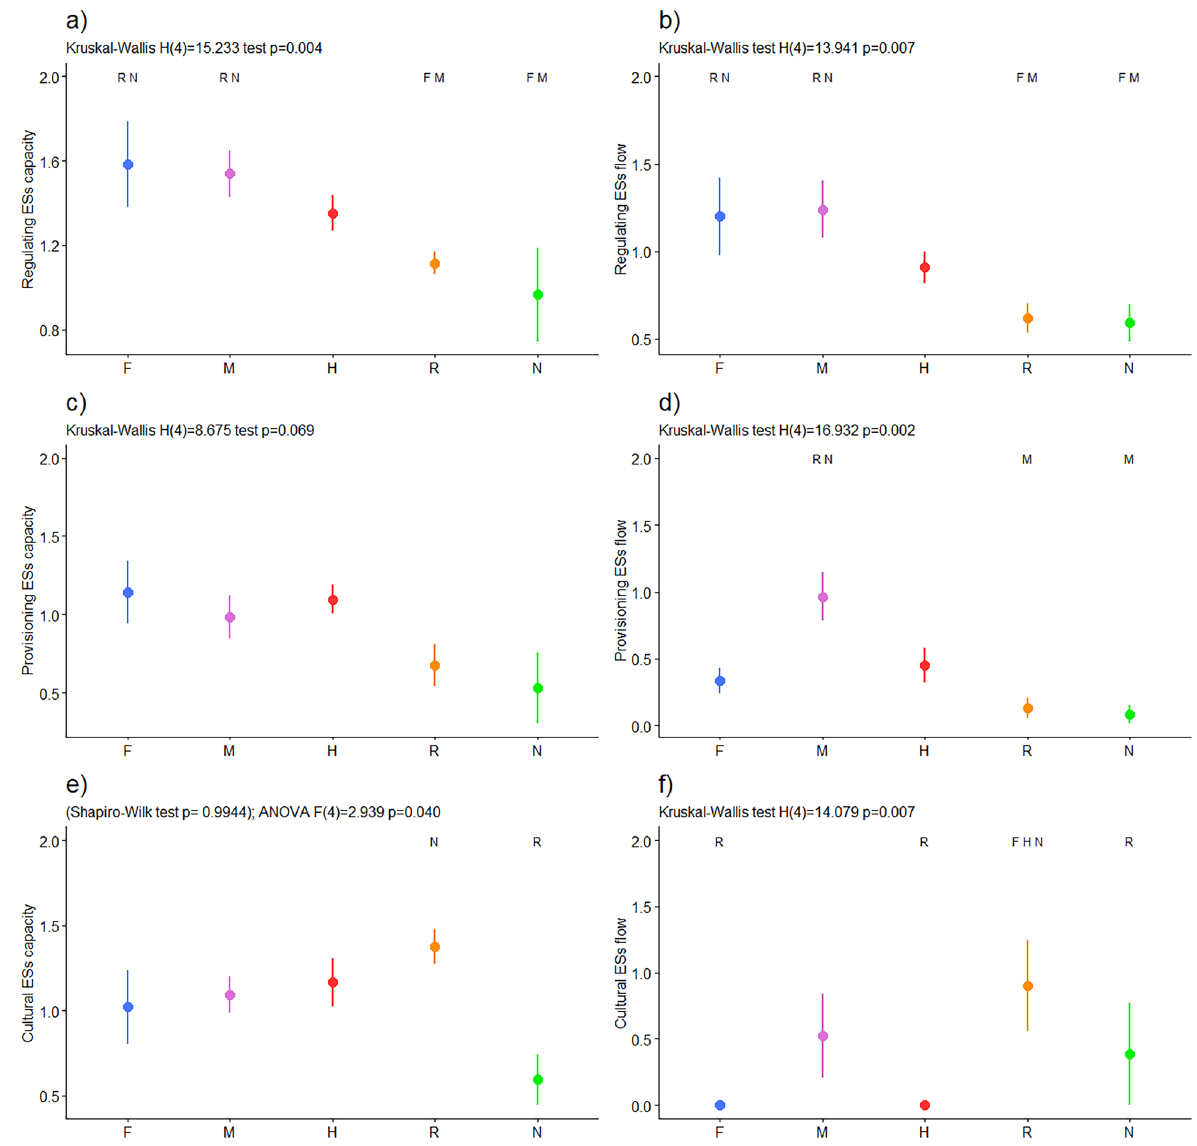
Figure 2. Ecosystem services aggregated indicators. The dots represent the means; the error bars show each group’s standard errors of ESs indicators. In the x-axis are reported the five groups: F = fish production; M = Multiple ESs; H = Hunting; R = Recreational; N = Not managed. The letters on the top of the plots indicate the group(s) to which the group is significantly different, at 95% confidence level. Panel ( a ) shows Regulating and Maintenance ESs capacity; ( b ) shows Regulating and Maintenance ESs flow; ( c ) shows Provisioning ESs capacity; ( d ) shows Provisioning ESs flow; ( e ) shows Cultural ESs capacity; ( f ) shows Cultural ESs